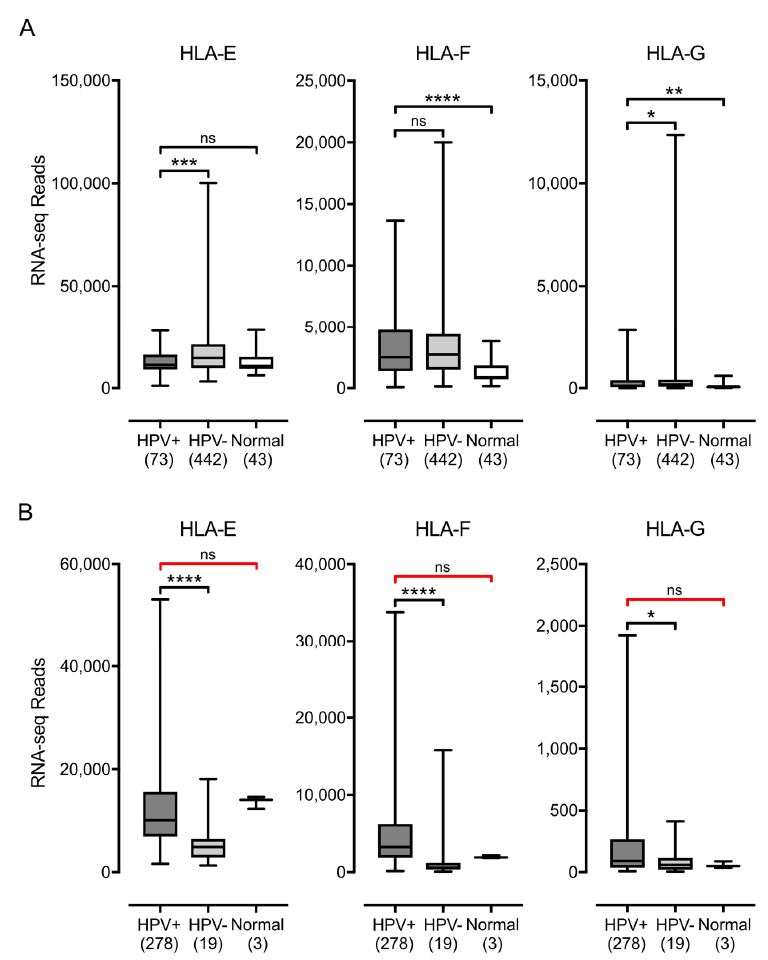
Figure 2. Expression of non-classical MHC-I heavy chain genes in head & neck or cervical carcinomas stratified by HPV status. Normalized RNA-seq data for the indicated MHC-I heavy chain genes was extracted from the TCGA database for the HNSC ( A ) and CESC ( B ) cohorts for HPV+, HPV − , and normal control tissues. Numbers in brackets refer to the number of samples included in each analysis. * p ≤ 0.05; ** p ≤ 0.01; *** p ≤ 0.001; **** p ≤ 0.0001; ns—not significant; red brackets